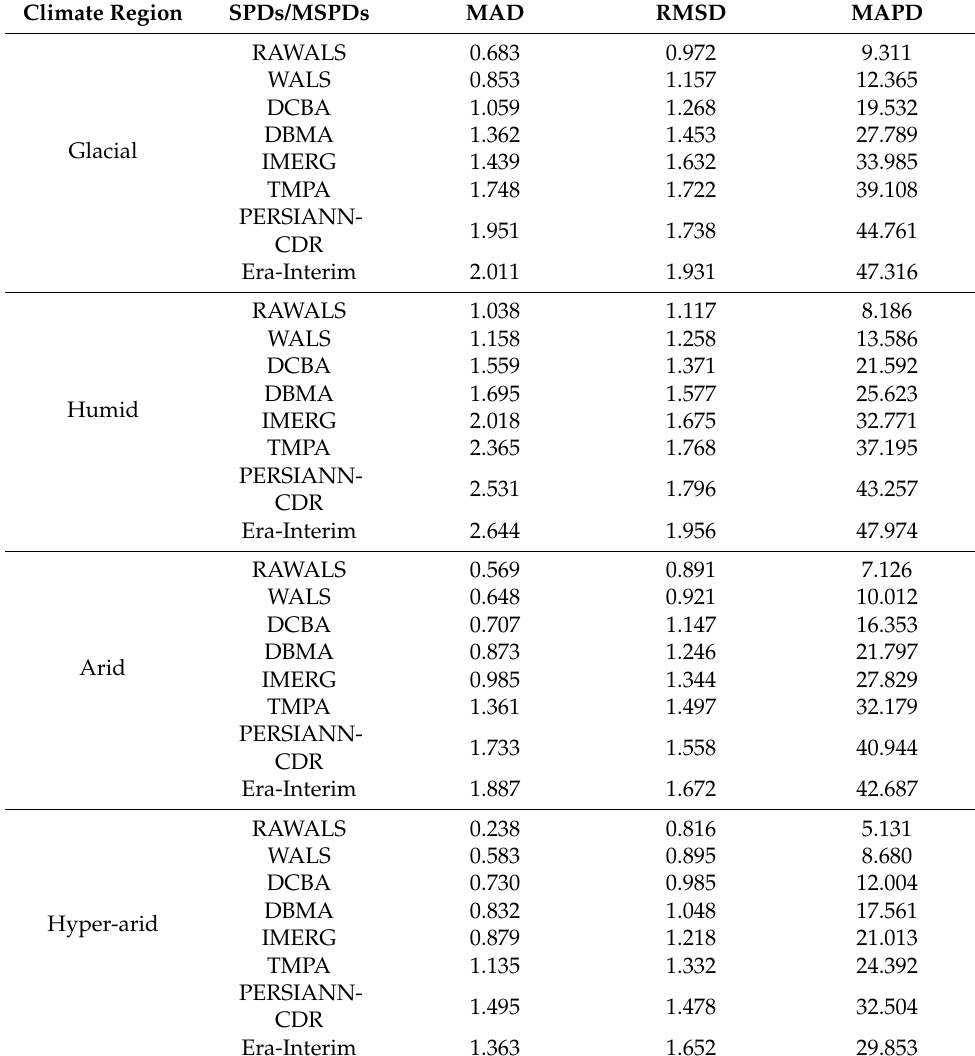
Table 4. Performance assessment of SPDs/MSPDs on a regional scale using SPI-1 estimated from RGs as a